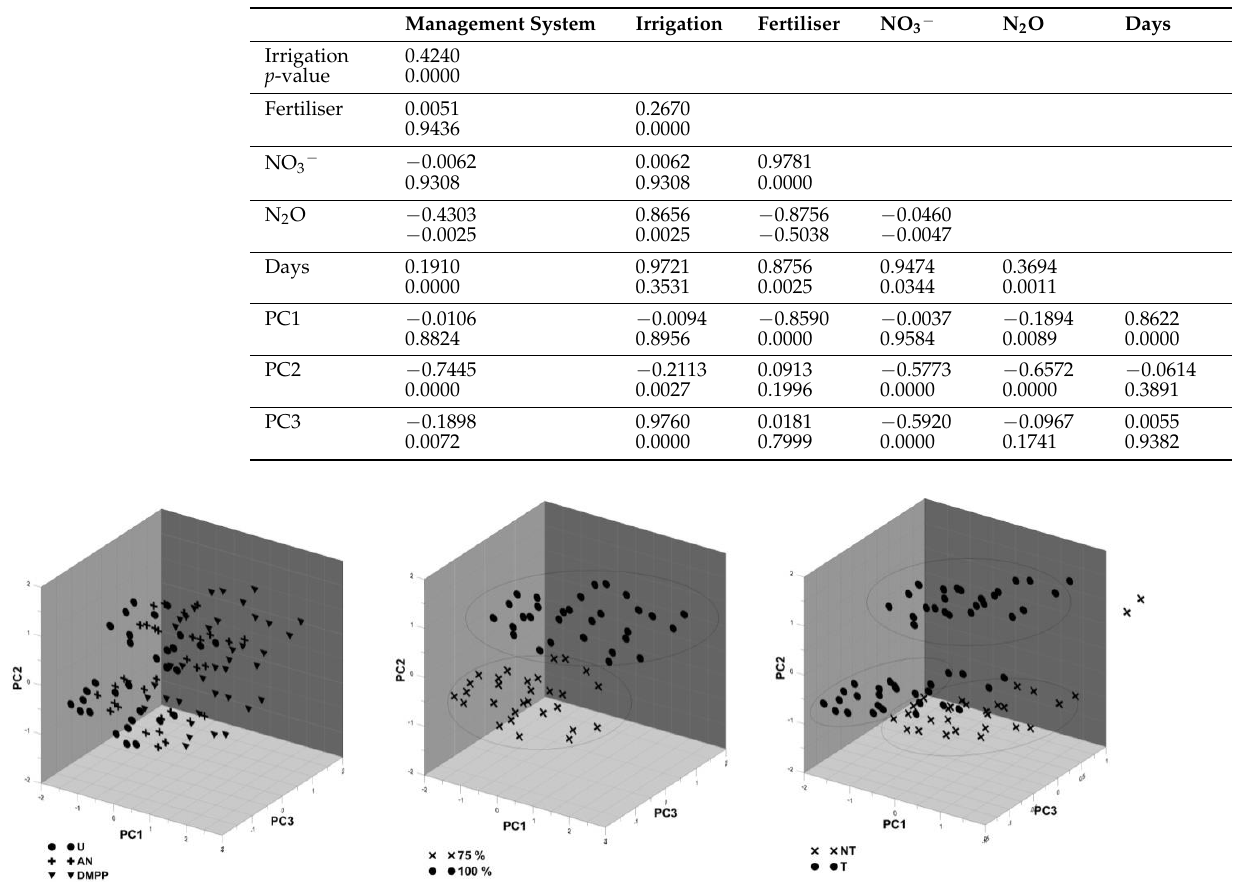
Figure 6. Spatial representation of the main components as a function of the interaction of the variables studied in pairs. The interaction between the management system and irrigation dose variables represents the first group formed by the emissions generated in the plots under conservation agriculture and the lower irrigation dose (75%). The second group is formed by the emissions in the traditionally tilled plots, which are also 75% irrigated, while the third group is made up of all the emissions generated in the plots irrigated at 100%,